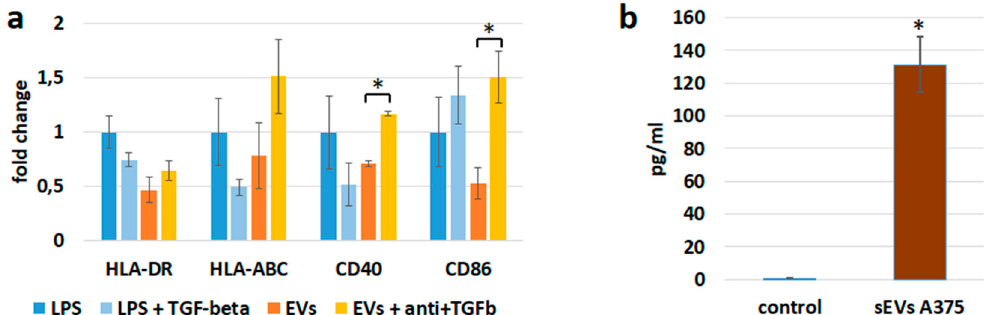
Figure 6. The down-regulation of receptor molecules on APCs could be partially caused by TGF- β . ( a ) Incubation of PBMCs di ff erentiated into DCs with 20 pg / mL recombinant TGF- β reduced the expression of CD40 and MHC class I and II molecules, measured by flow cytometry. Reduced expression of all four antigens after incubation with sEVs derived from A375 melanoma cells was reversed in the presence of anti-TGF β antibodies (1 µ g / mL). The expression of MHC molecules, CD40 and CD80, was evaluated by flow cytometry. The mean fluorescence intensities (MFI) relative to untreated control cells are shown. Significant di ff erences between samples treated with sEVs or with sEVs and anti-TGF- β antibodies are marked by asterisks. ( b ) TGF- β was measured by a cytometric bead assay in A375 cell-derived sEVs. A sample without sEVs served as a negative